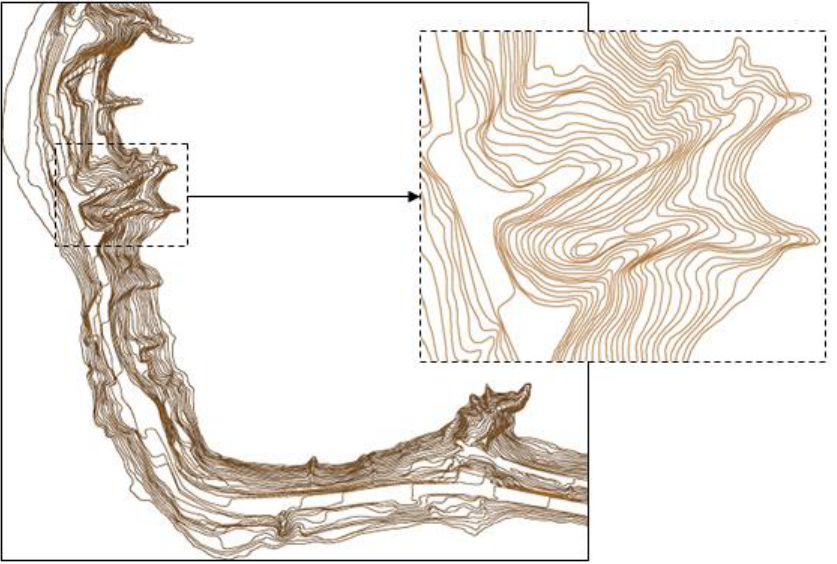
Figure 17. Initial data of 52 contour lines composed of 72,723 shape points.